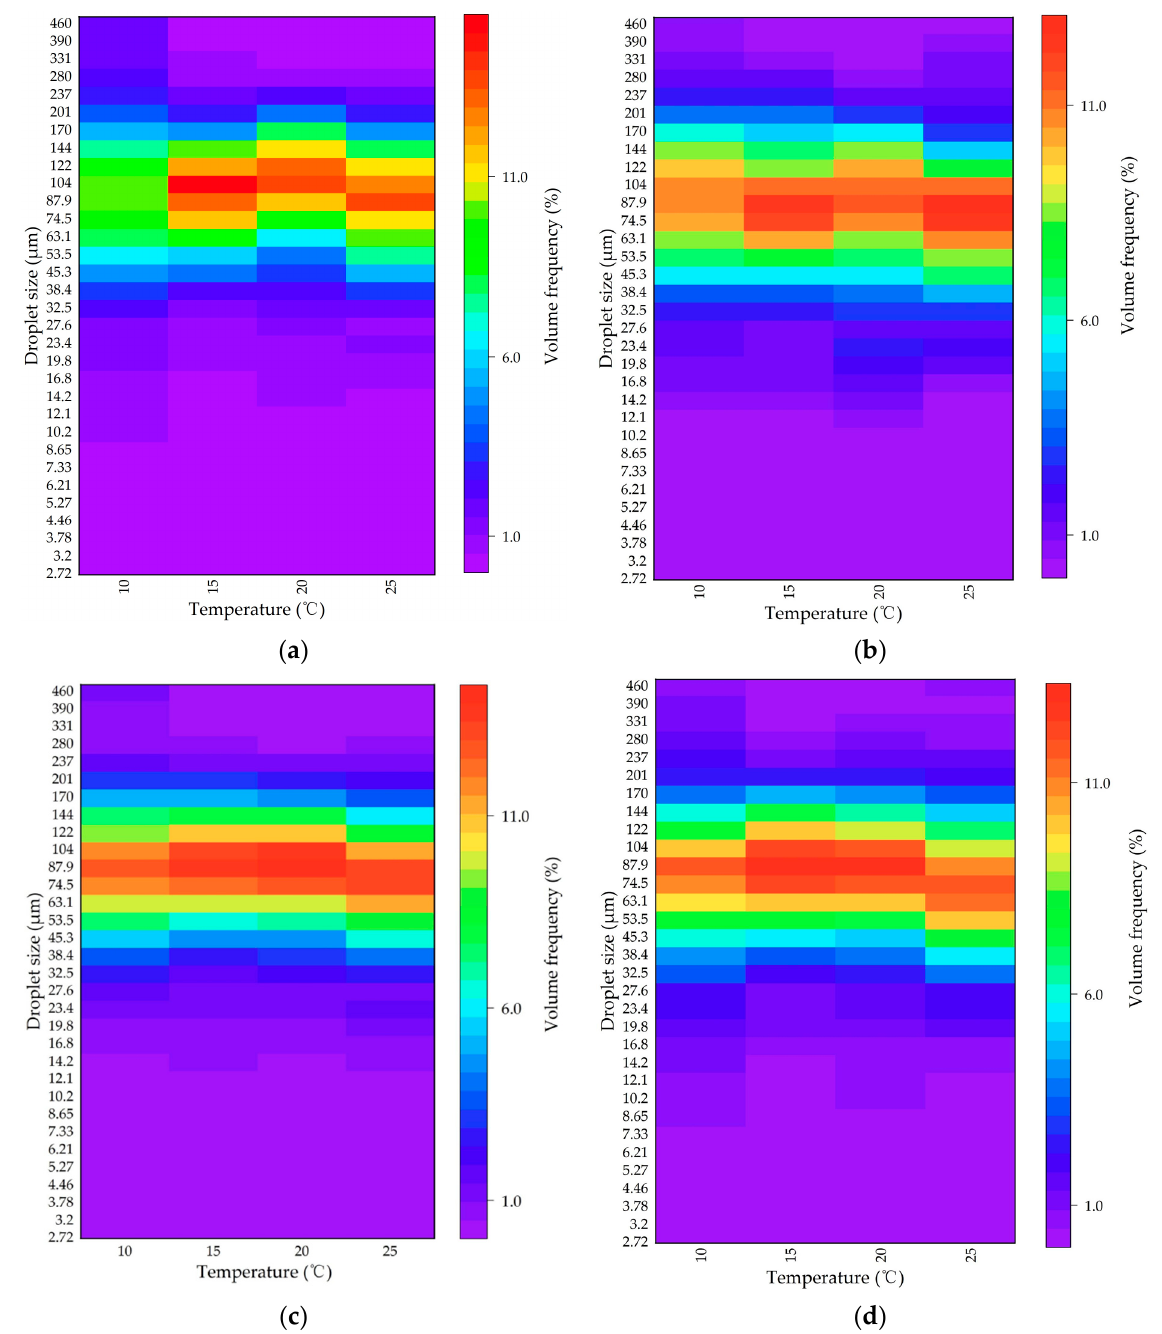
Figure 6. Heatmap of the volumetric frequency distribution of the dispersed oil droplets under different temperatures with ( a ) 13 μ m PS, ( b ) 13 μ m PE, ( c ) 106 μ m PS, and ( d ) 106 μ m PE MPs.